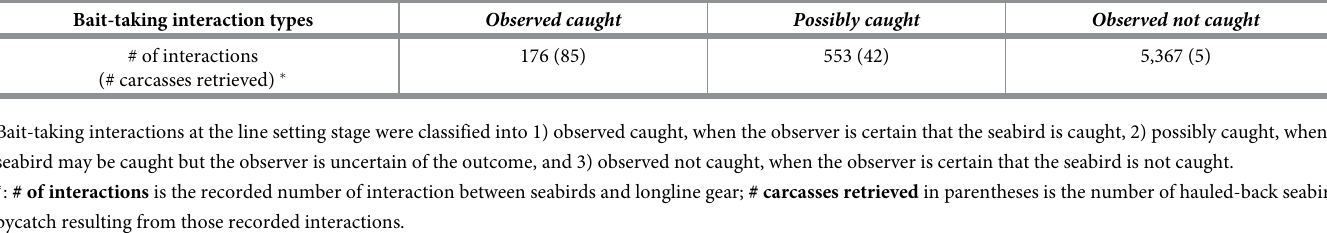
Table 1. Counts of bait-taking interaction categories and the associated counts of retrieved carcasses from Brothers et al. [7]. Bait-taking interaction